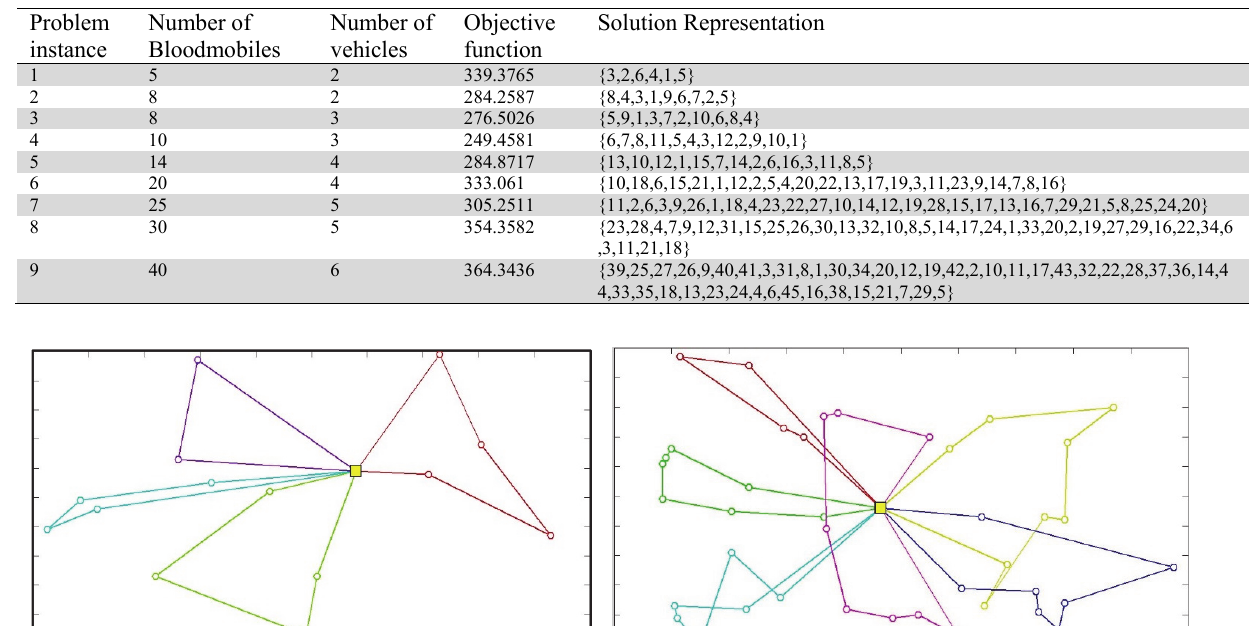
Characteristics of the second model